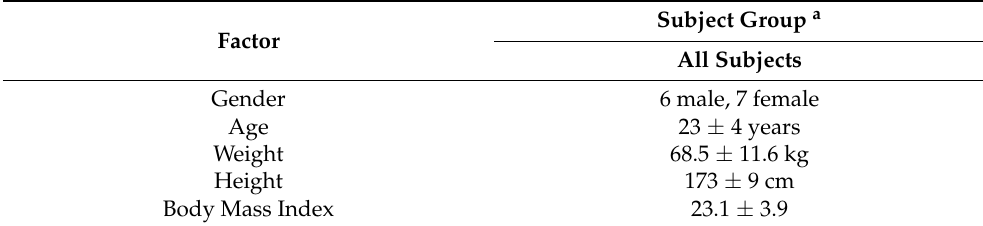
Table 1. Study Cohort